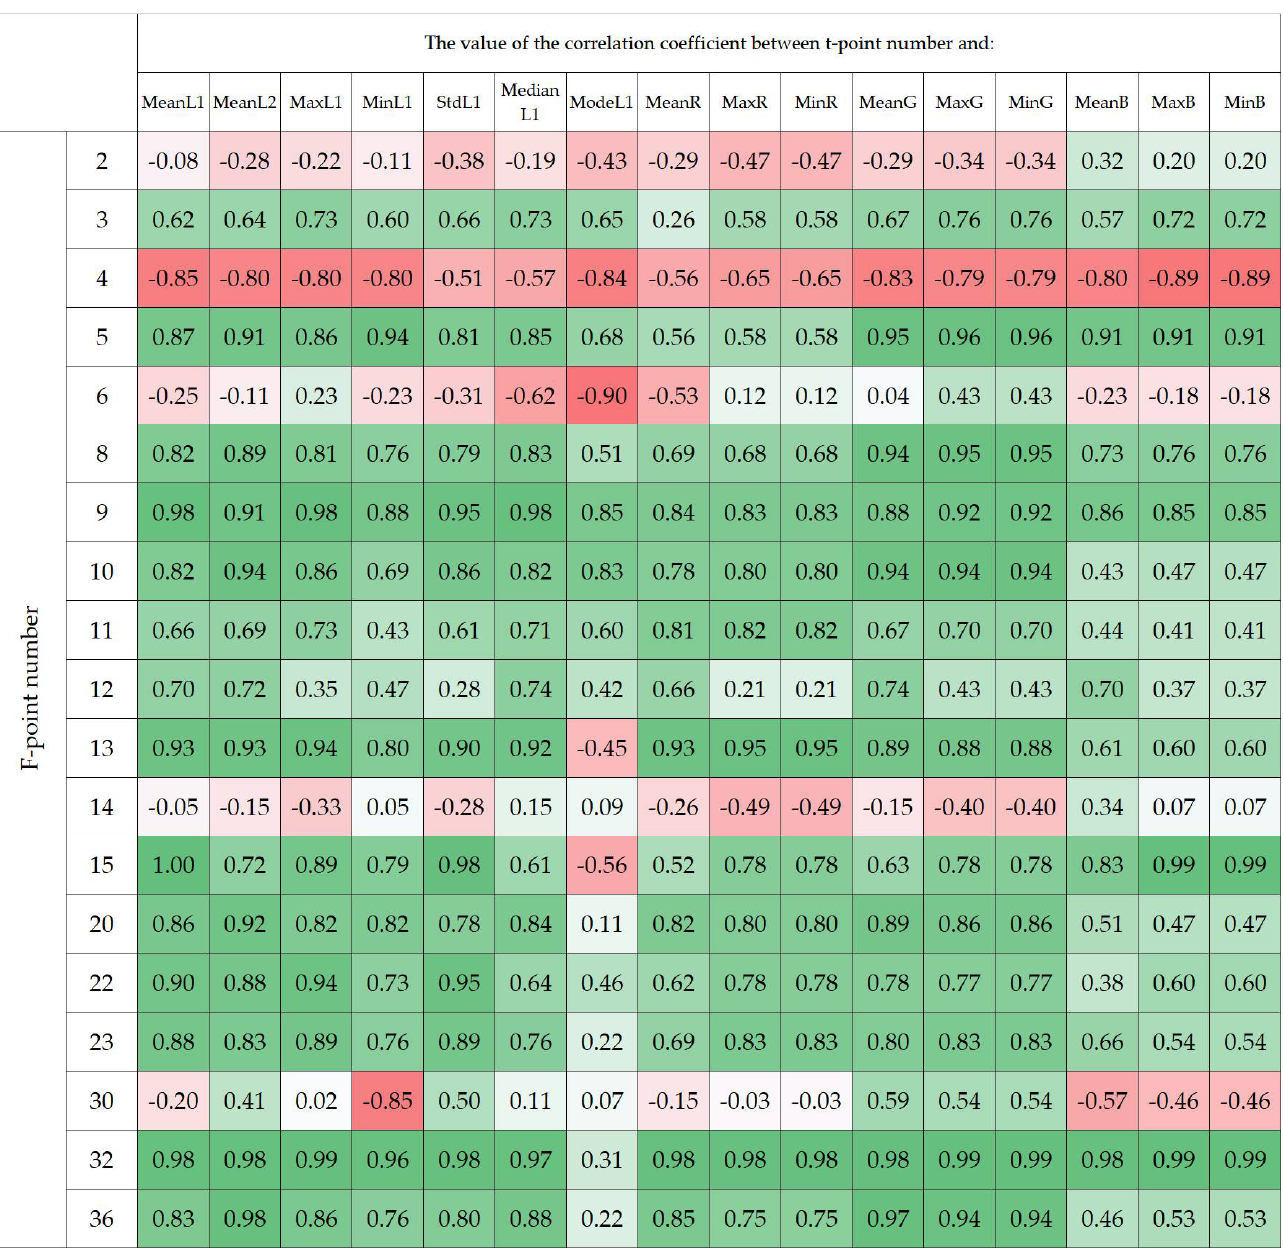
Figure 21. The value of the correlation coefficient between t-point number and the other F-point features.